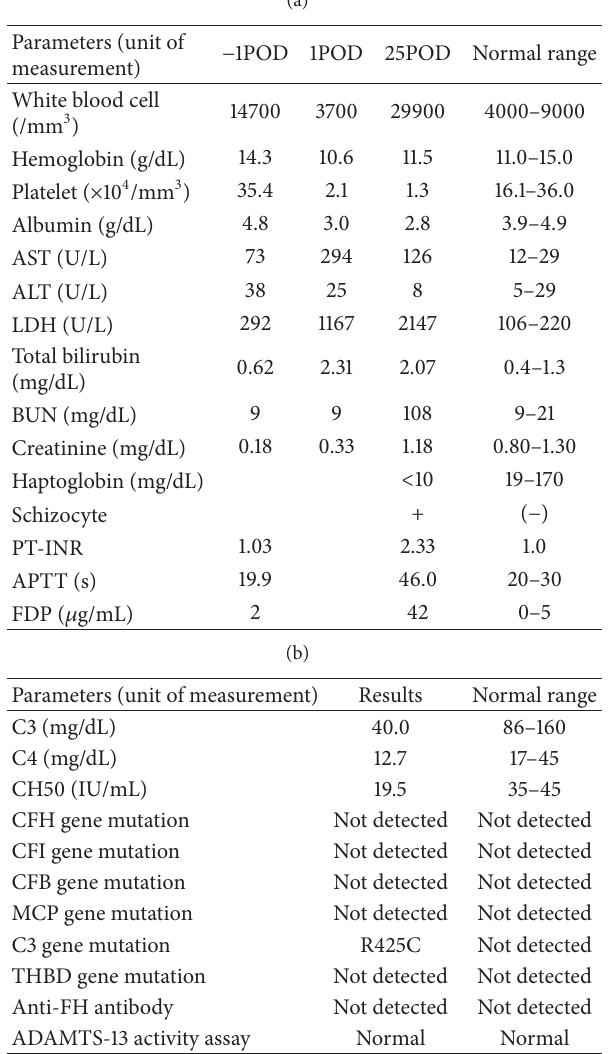
Table 1: (a) Time series of patient’s laboratory data. (b) Specific data of the patient for aHUS